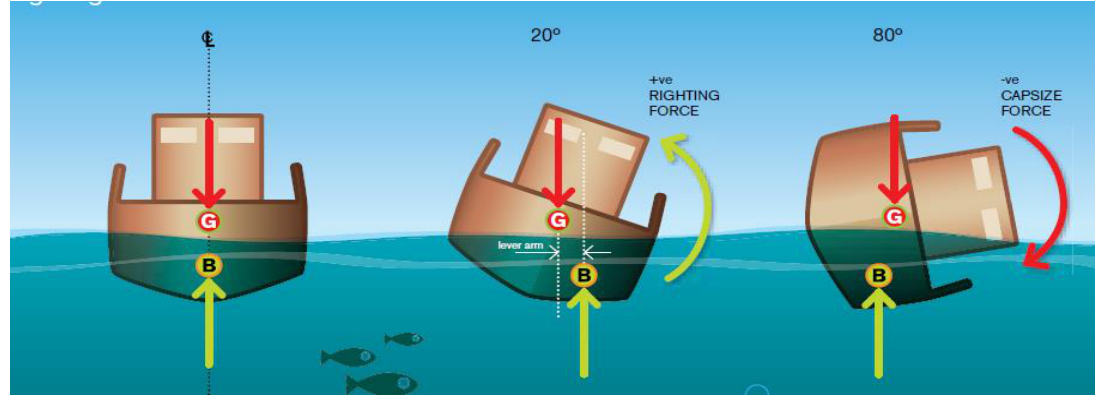
Figure 1: Changes in vessel's stability